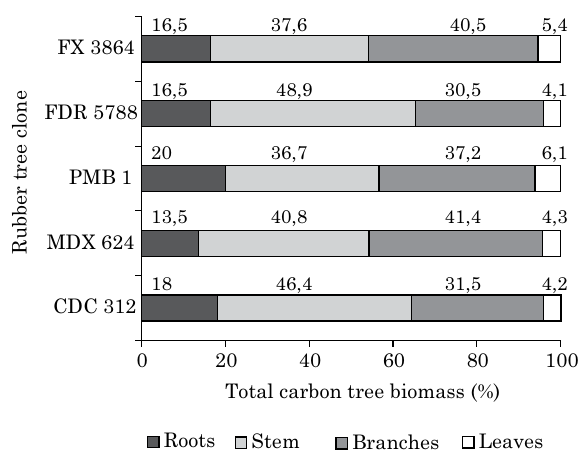
figure 2. individual contribution (percentage) of tree biomass components across different rubber tree clones.